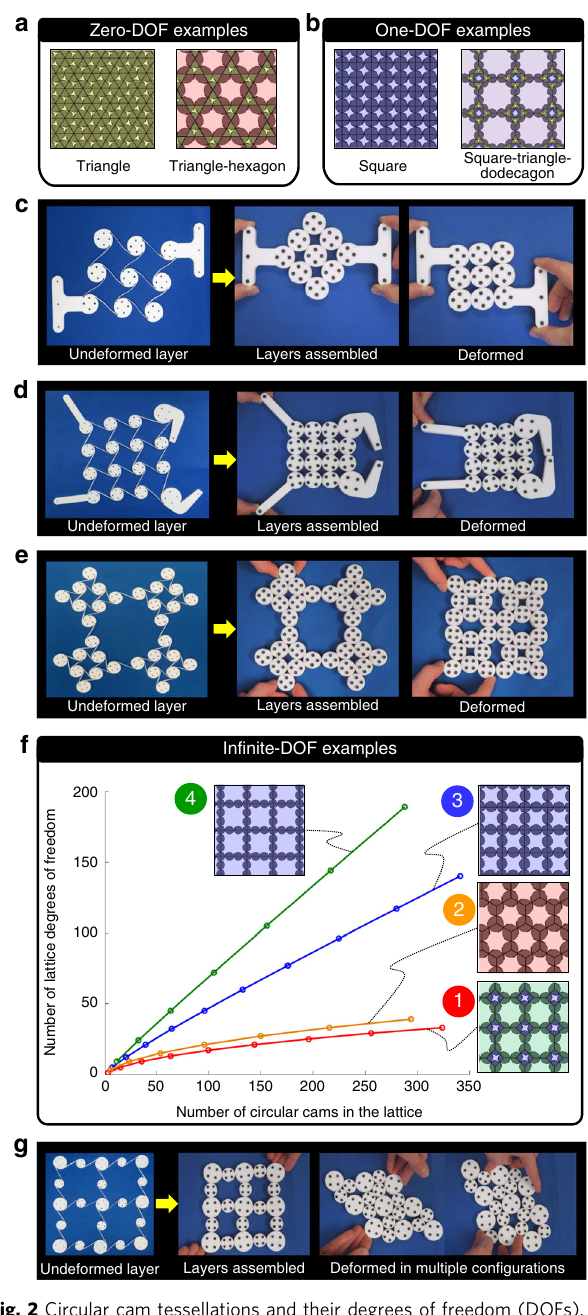
Fig. 2 Circular cam tessellations and their degrees of freedom